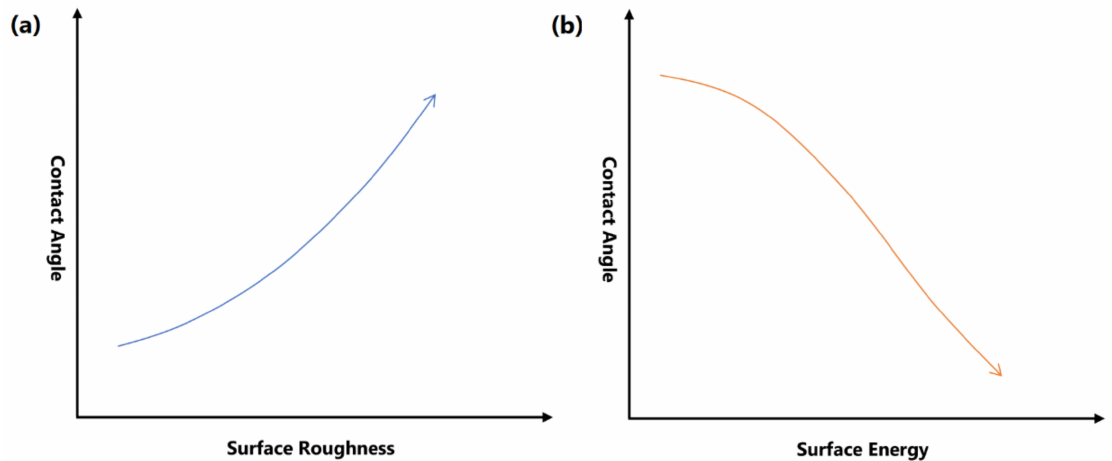
Figure 5. The correlation between surface roughness and surface energy with water contact angle: ( a ) Higher surface roughness leads to higher contact angle due to presence of air bubbles within surface protrusions which reduces contact area and frictional drag of water droplets with the surface; ( b ) Lower surface energy leads to higher contact angle due to poor adherence of water droplets to the